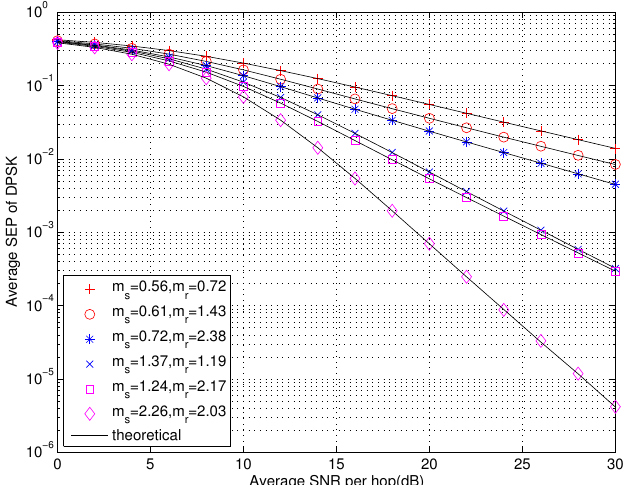
Figure 1. Average signal error probability (SEP) of the differential phase shift keying (DPSK) modulation. SNR: signal-to-noise